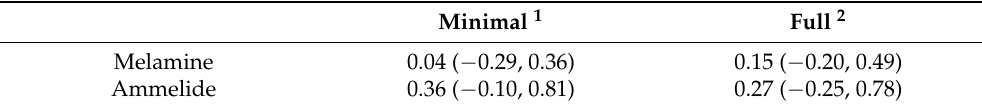
Table 3. Estimated regression coefficients (95% CI) for associations of FAFH (versus FAH) with urinary melamine and ammelide